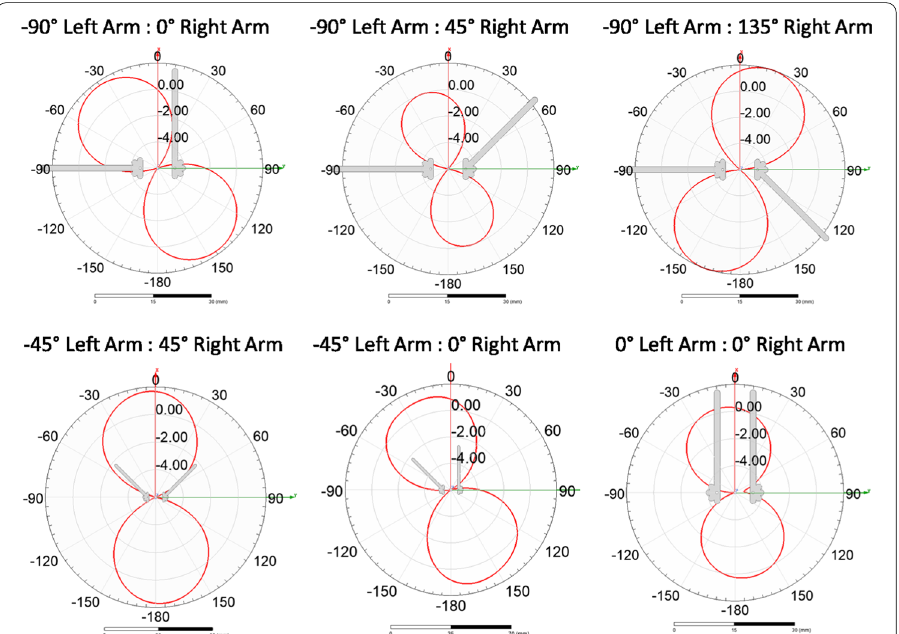
Fig. 11 Simulated radiation pattern 1. Simulated radiation patterns for a liquid metal dipole antenna with varying angles between the radiating elements